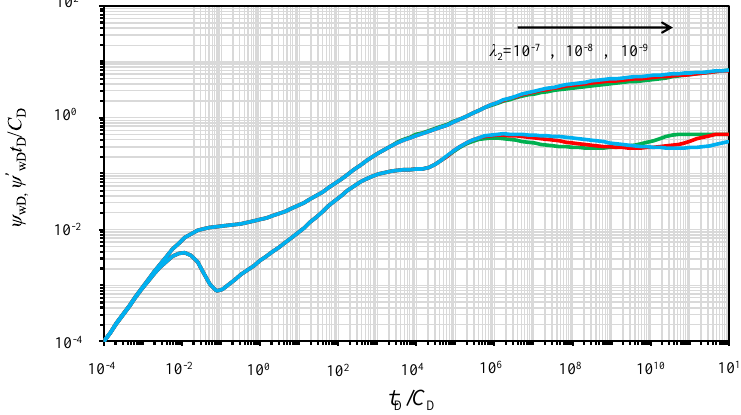
Figure 15. Effect of the inter-porosity flow parameter on the PPR and PPD.